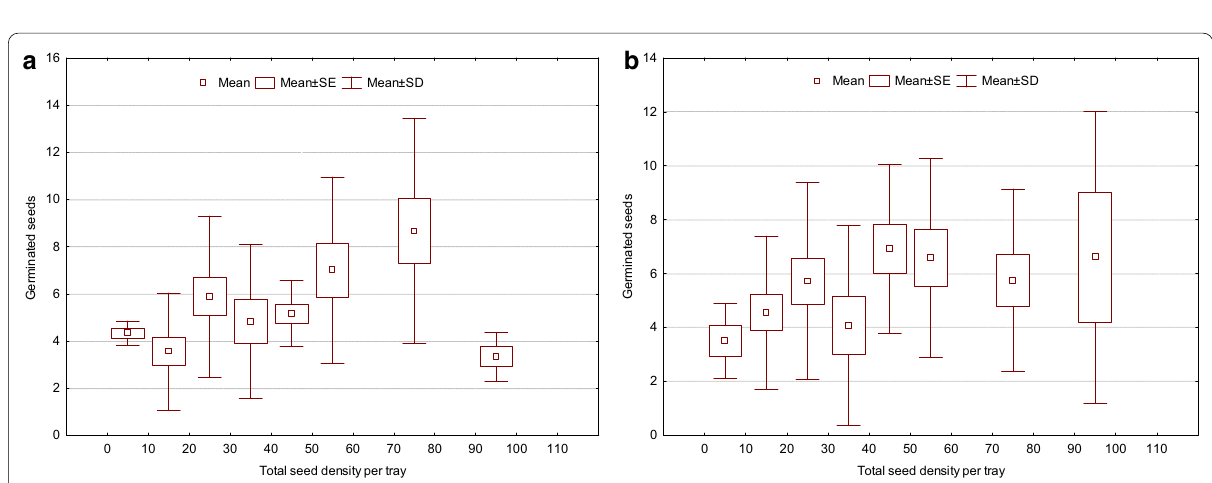
Fig. 8 Overall variation in germination of bird-ingested seeds for Z. mucronata ( A ) and O. subsp. africana ( B ) across seed density levels (i.e., 10–100 seeds per tray) with different competing